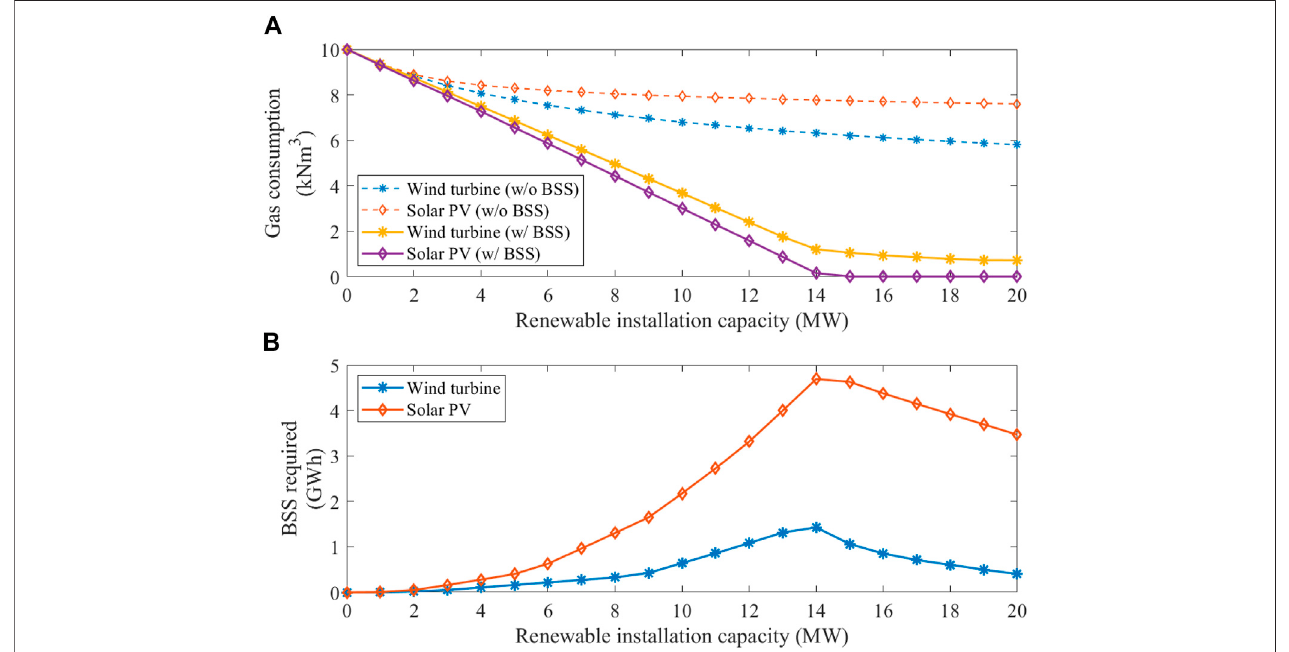
FIGURE 5 | Boiler gas consumption and required ESS capacity according to the installation capacity of renewable